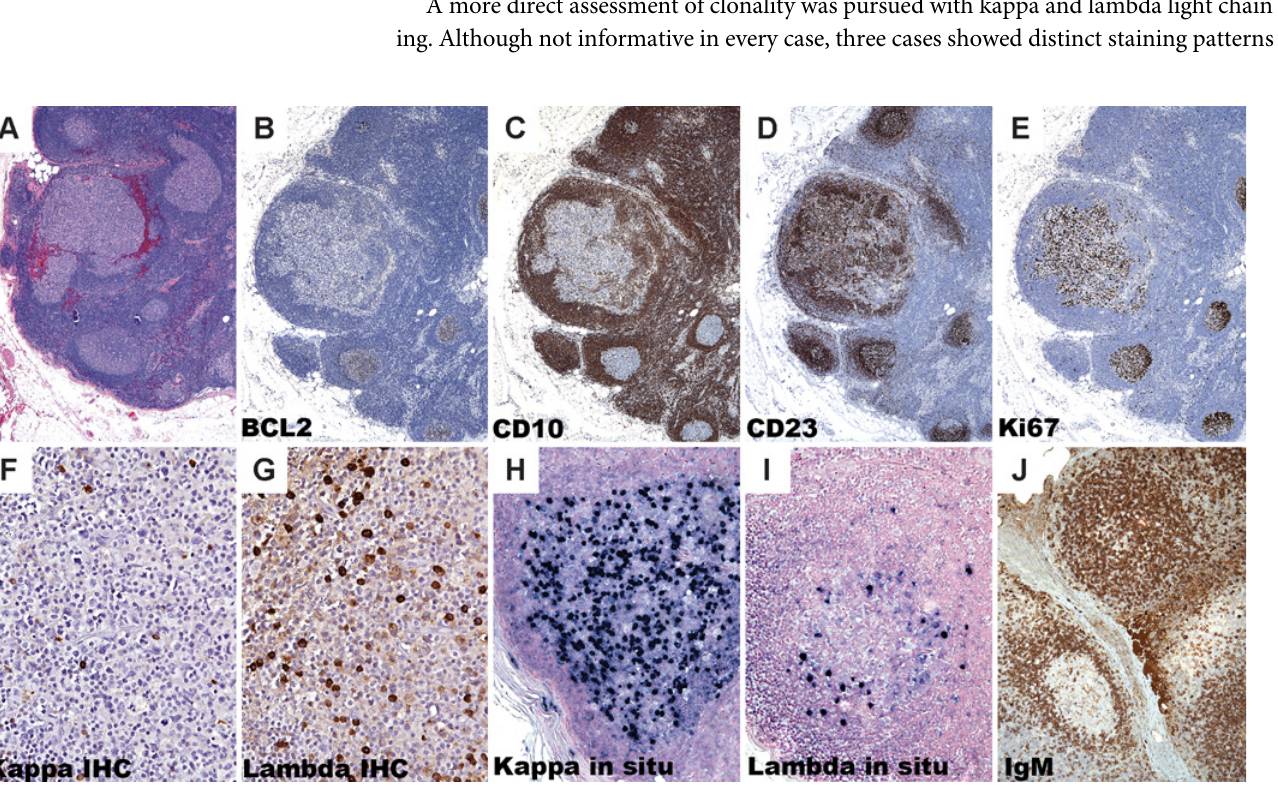
Table legend 3. Atypical large cells in involved follicles were scored POS (positive) or NEG (negative); ND: Not done due to insuf fi cient tissue